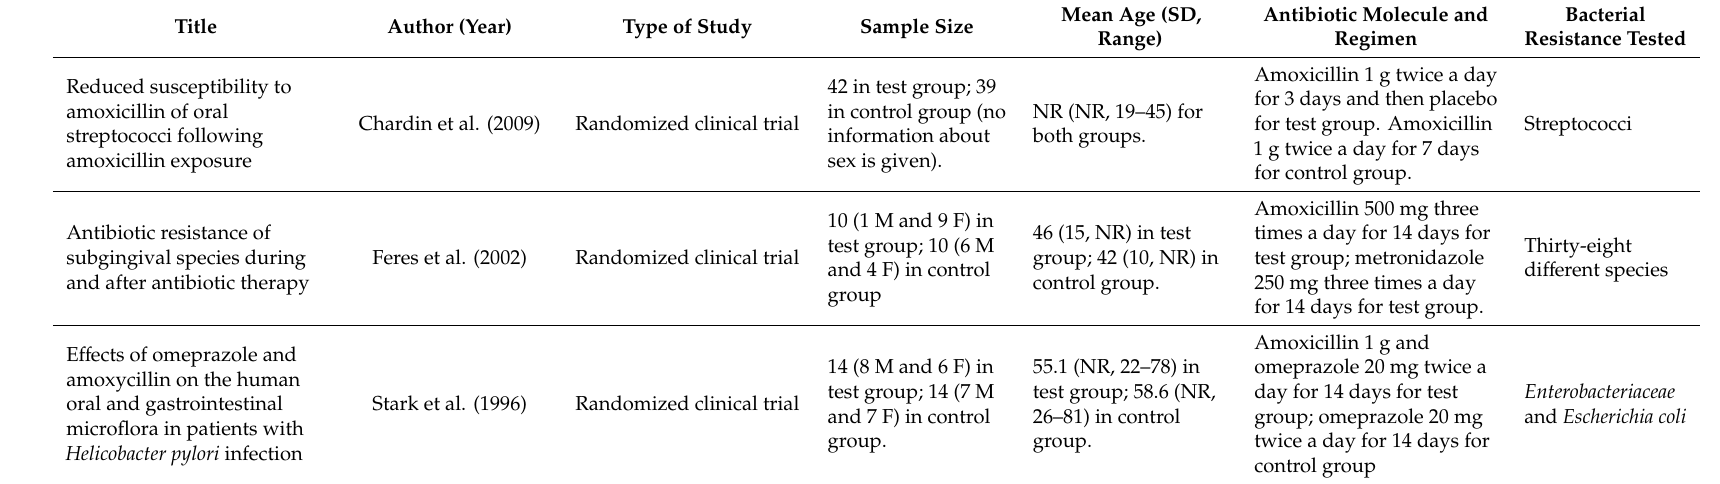
Table 1. Characteristics of the included